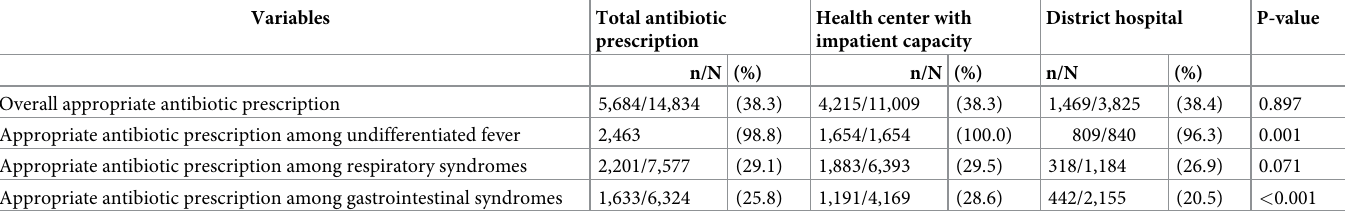
Table 3. Proportion of appropriate antibiotic prescriptions in each selected category and by facility type in the rural health district of Fore´cariah, Guinea, 2014–